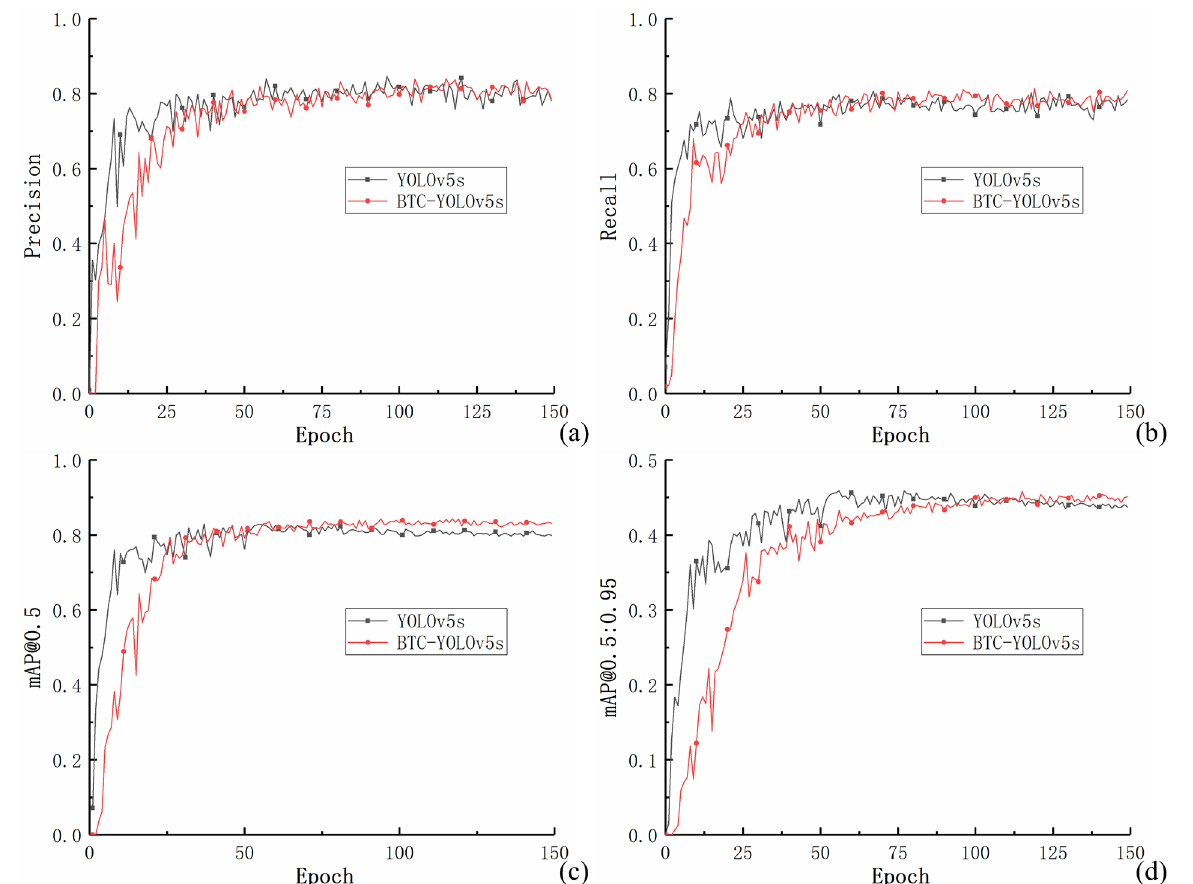
Figure 9. Evaluation metrics of different models, where ( a ) is a comparison of precision curves be-